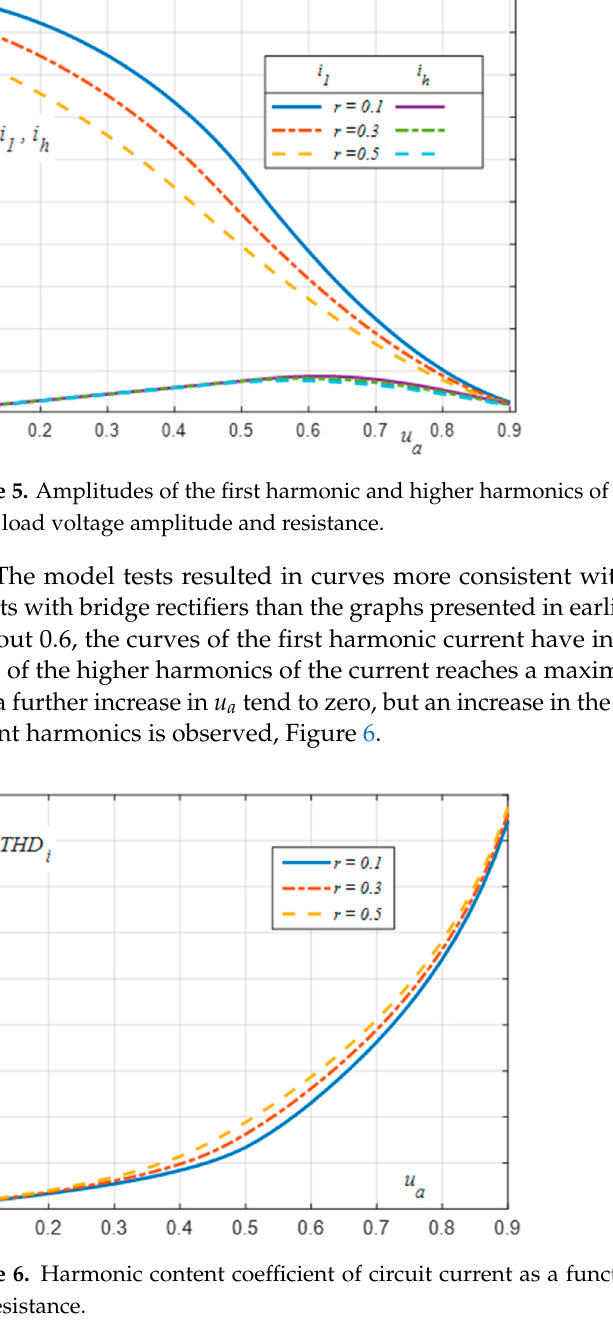
Figure 7. Amplitudes of the first harmonic and higher harmonics of the load voltage as a function of load voltage amplitude and resistance. The relationship between the higher harmonics and the fundamental harmonic of the load voltage is determined by THD u , whose graph as a function of u a and r is shown in Figure 8.